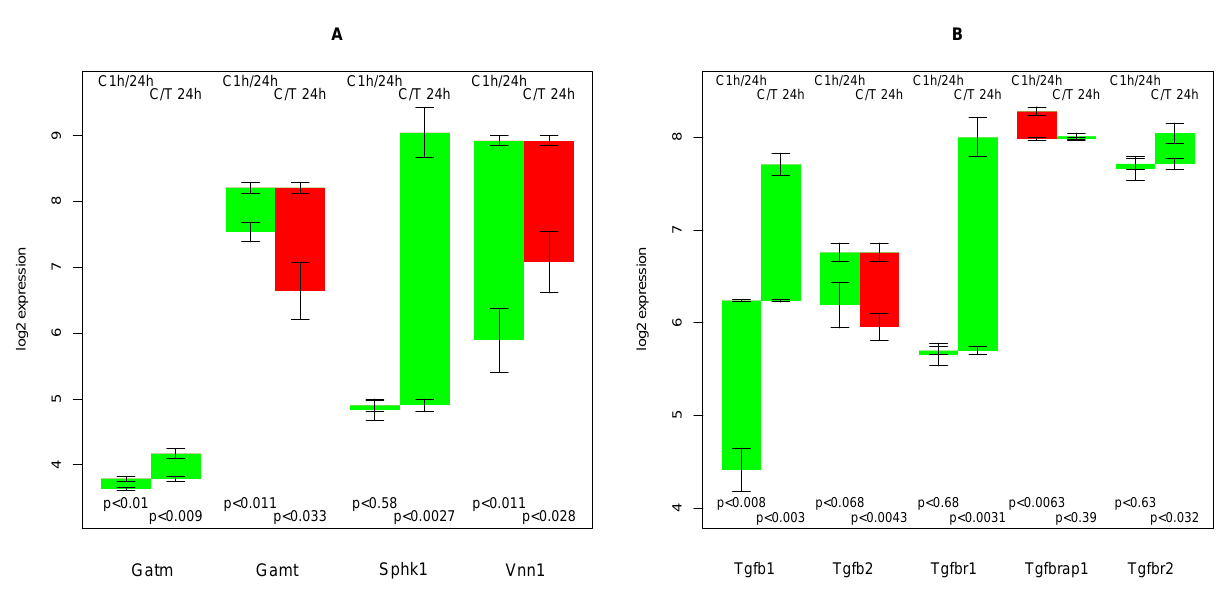
Figure 8. (A) Regulation of creatine synthesis and of some solitude genes; (B) Regulation of selected genes encoding TGF β , its receptors and related